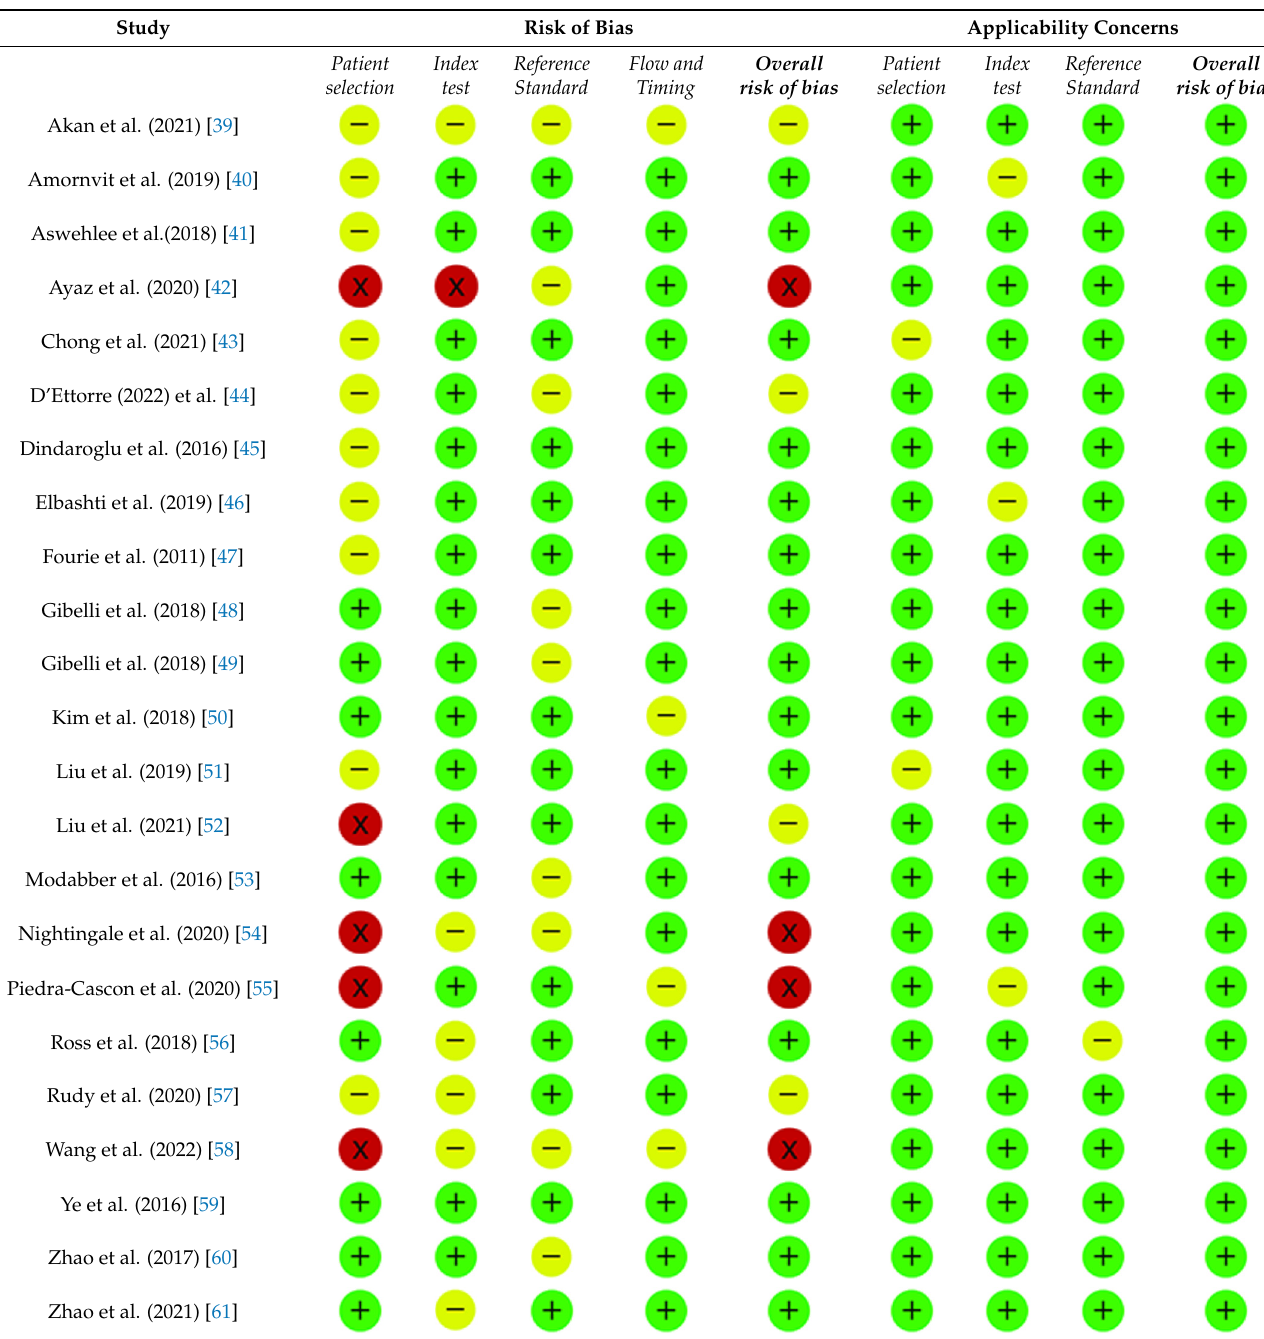
Table 2. Risk of bias and application concerns according to the QUADAS-2 guidelines.